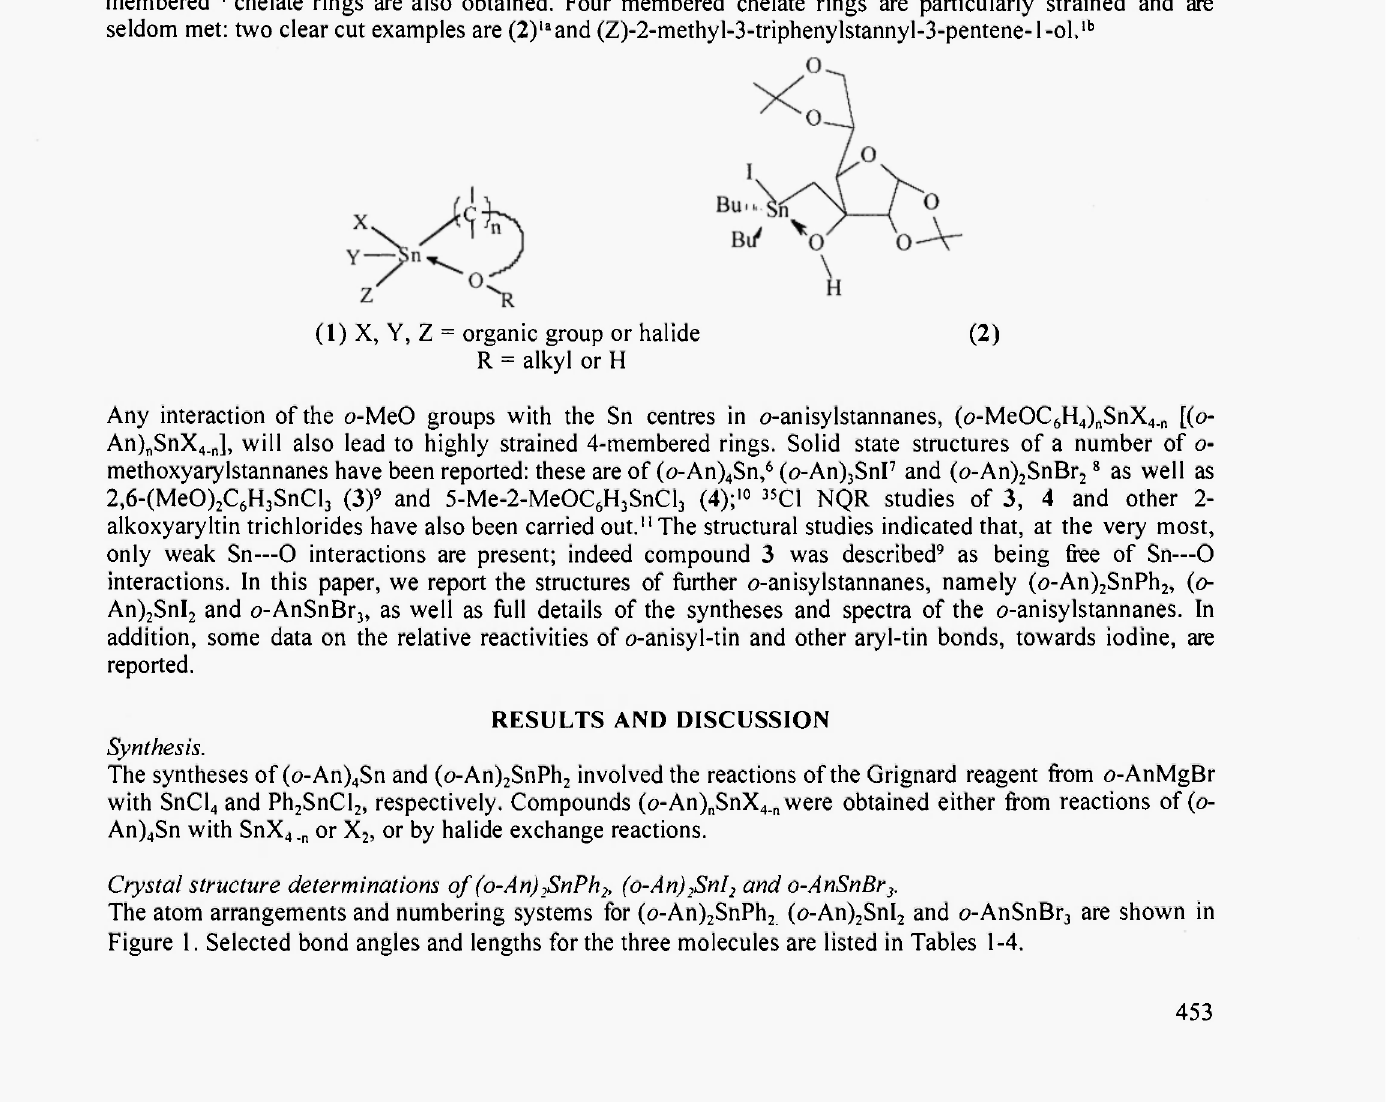
Figure 1. Selected bond angles and lengths for the three molecules are listed in Tables